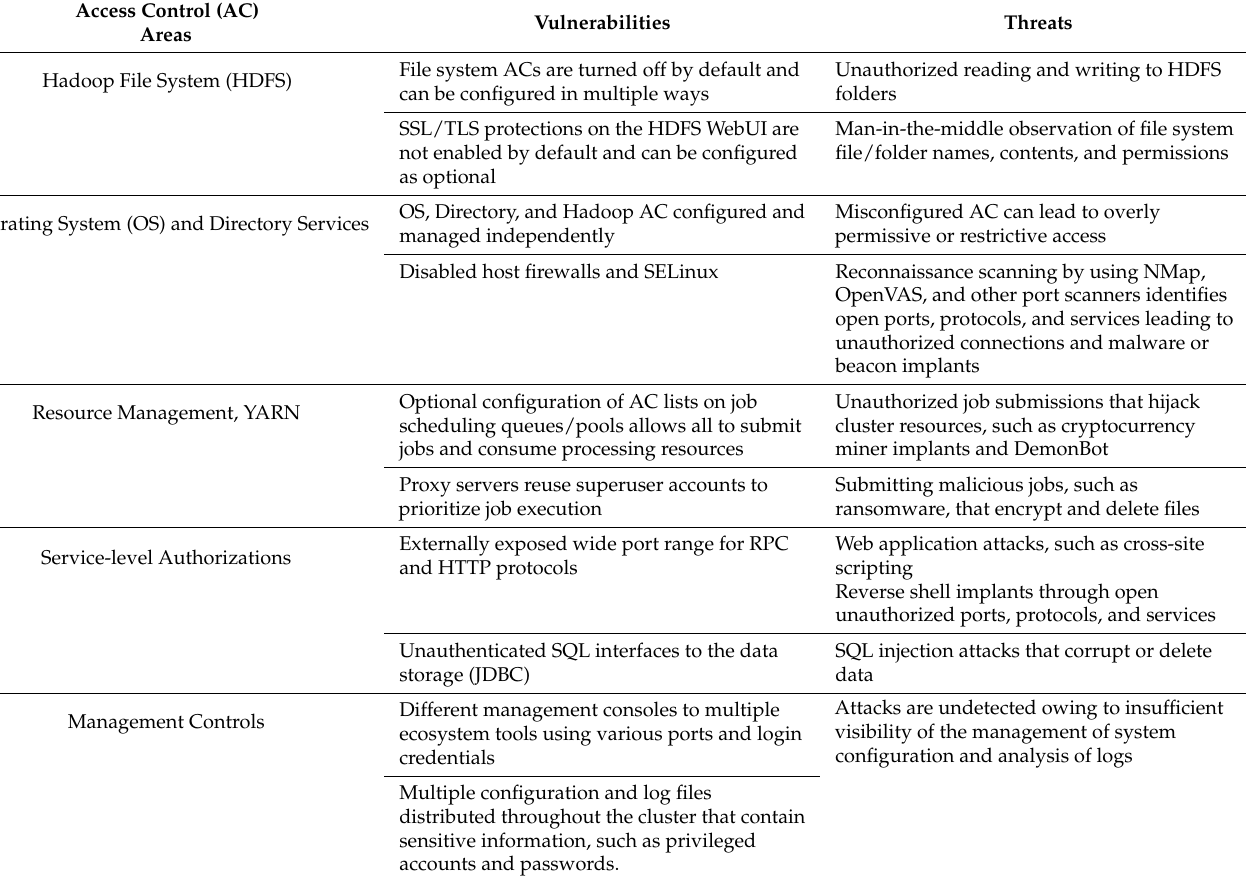
Table 3. Hadoop AC areas, vulnerabilities in the attack path, and patterns of threats posed by